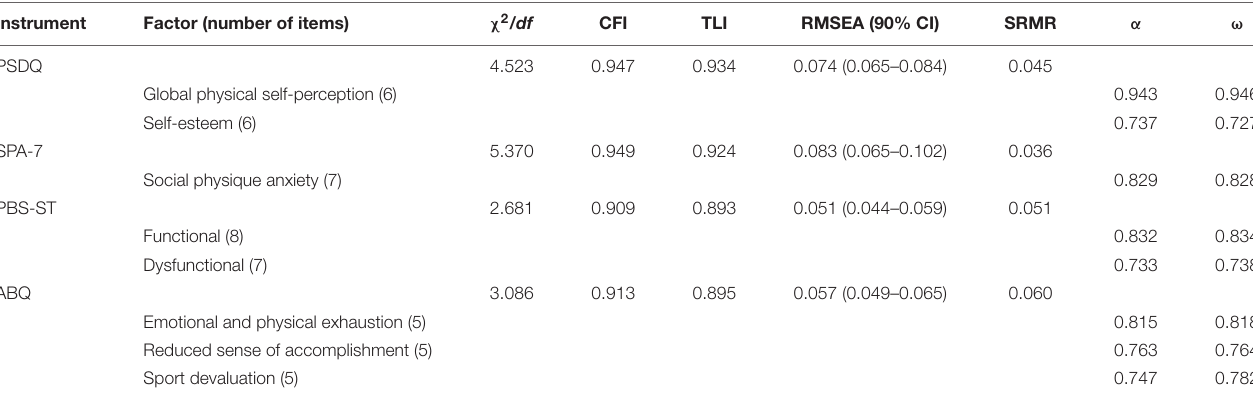
TABLE 3 | Confirmatory Factor Analysis Fit Indices and Reliability Values of the Measures.